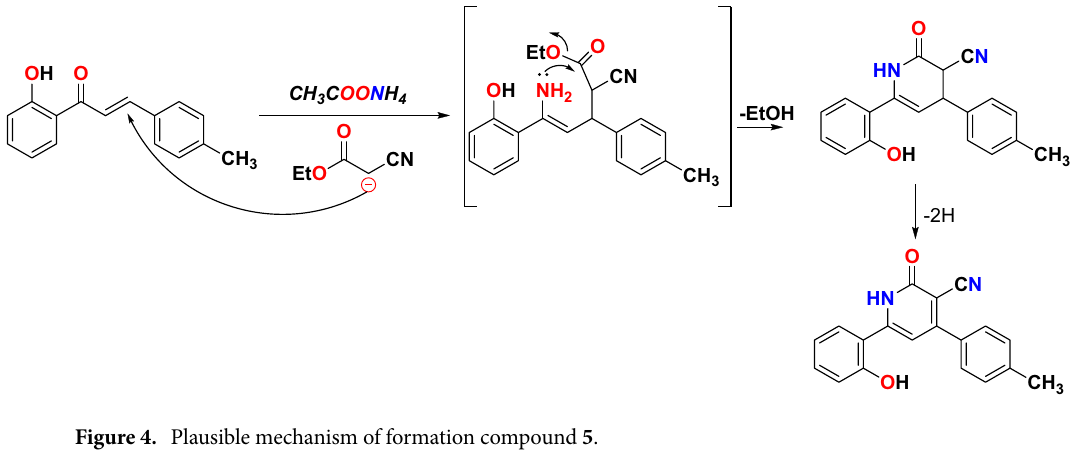
Figure 4. Plausible mechanism of formation compound 5 .